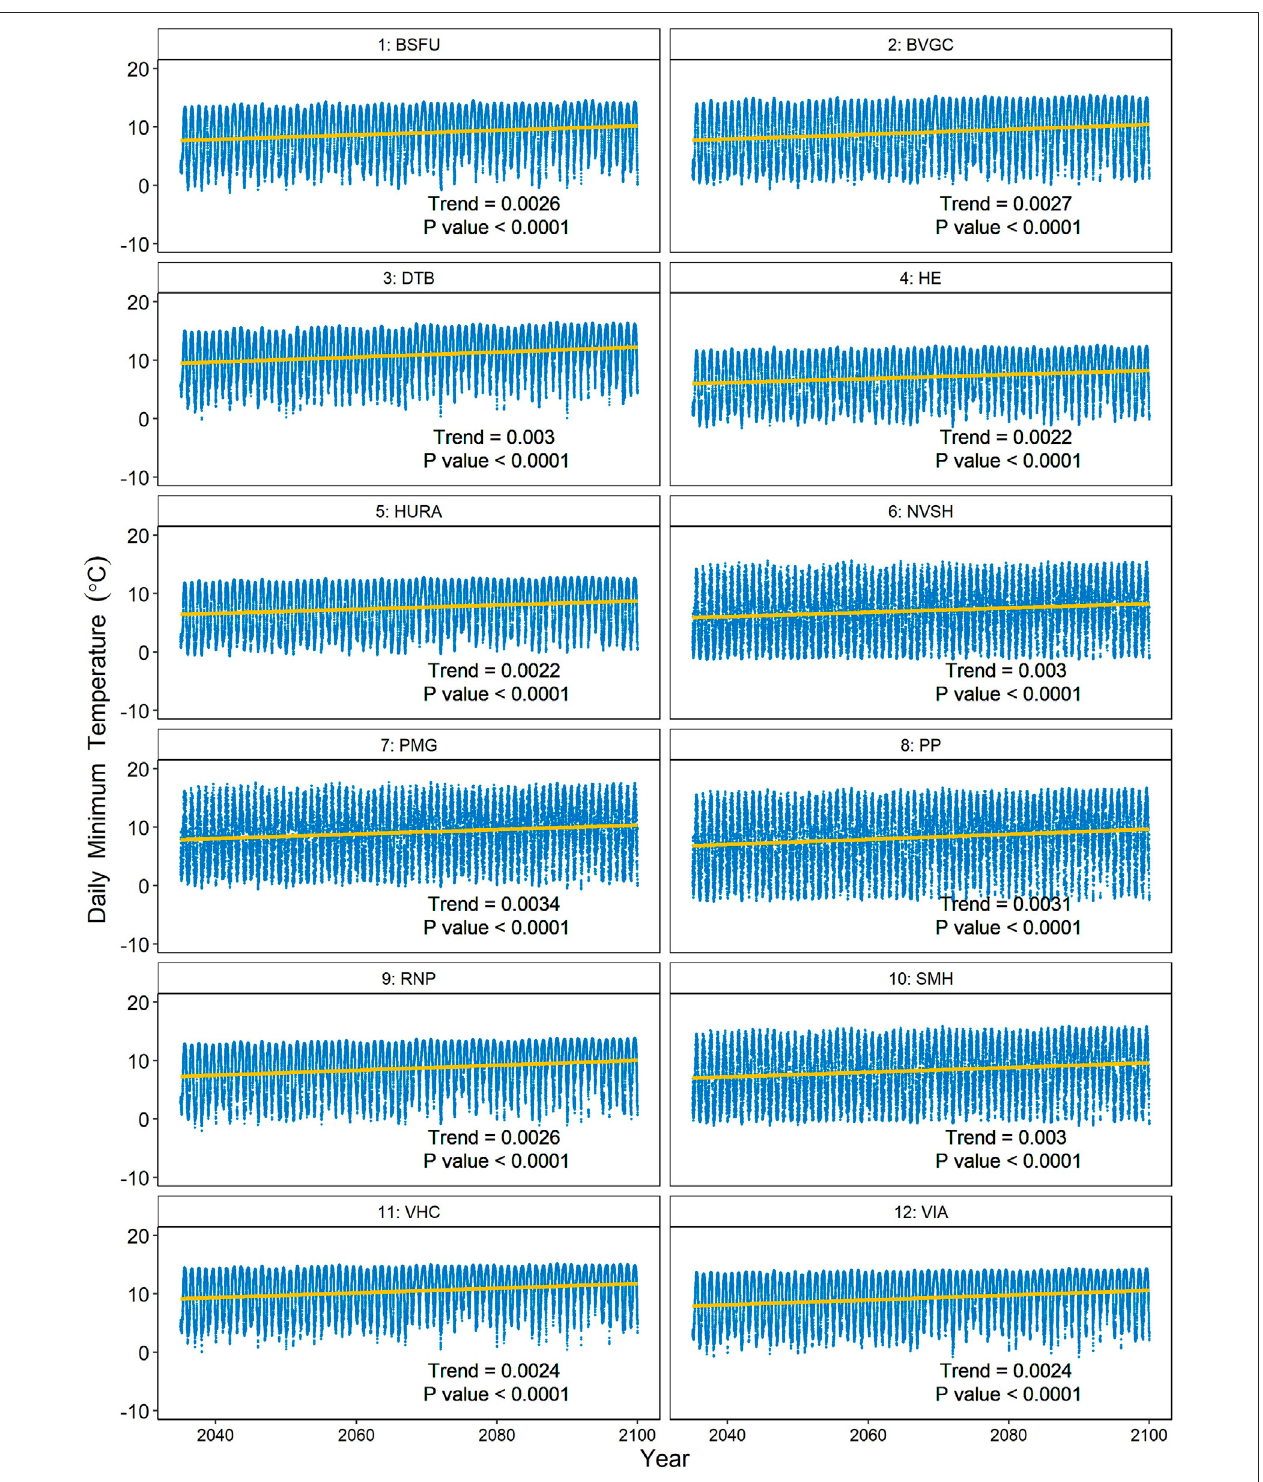
FIGURE 6 | Projected trends of daily minimum temperature between 2035 and 2100.